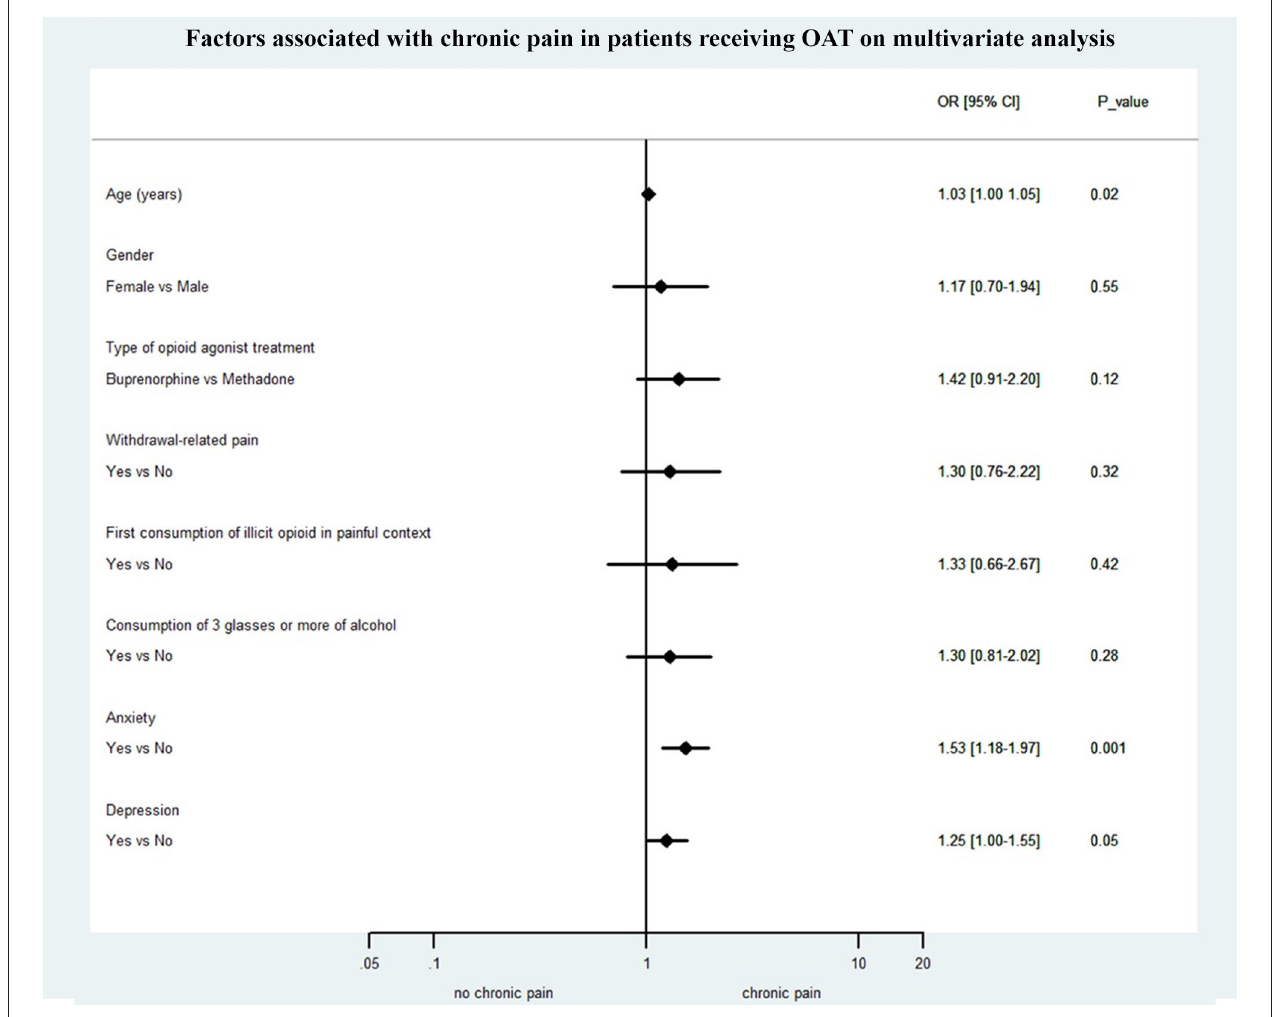
FIGURE 2 | Factors associated with chronic pain on multivariate